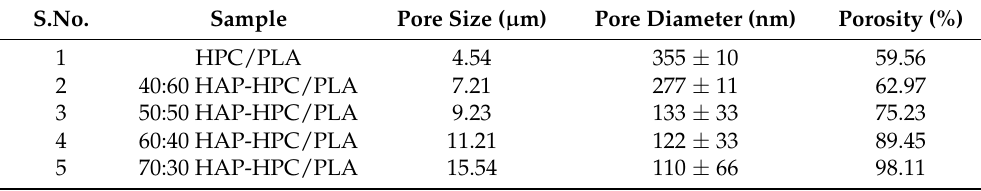
Table 6. The fiber pore size and diameter calculated from SEM images and solvent replacement method.